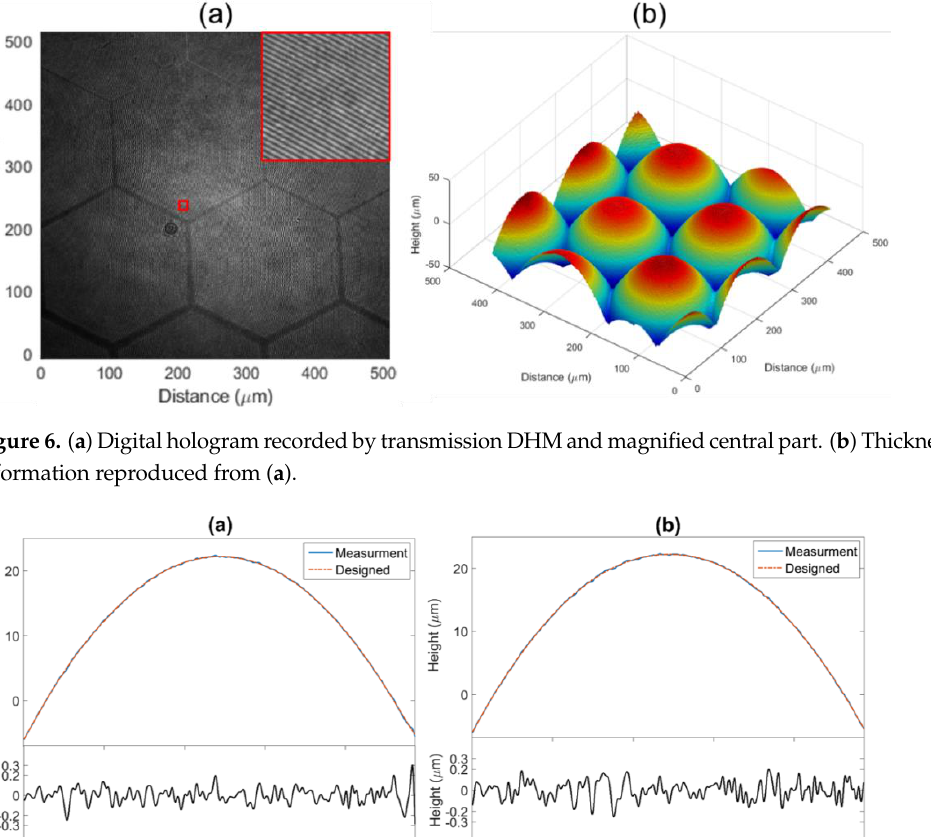
Figure 7. Sample curves and roughness measurements in the vertical and horizontal directions of the microlens. Measurement (blue line) and designed (red dashed line) height is shown at the top of each picture, the residue is illustrated at the bottom. ( a ) Horizontal direction, ( b ) Vertical direc- tion.